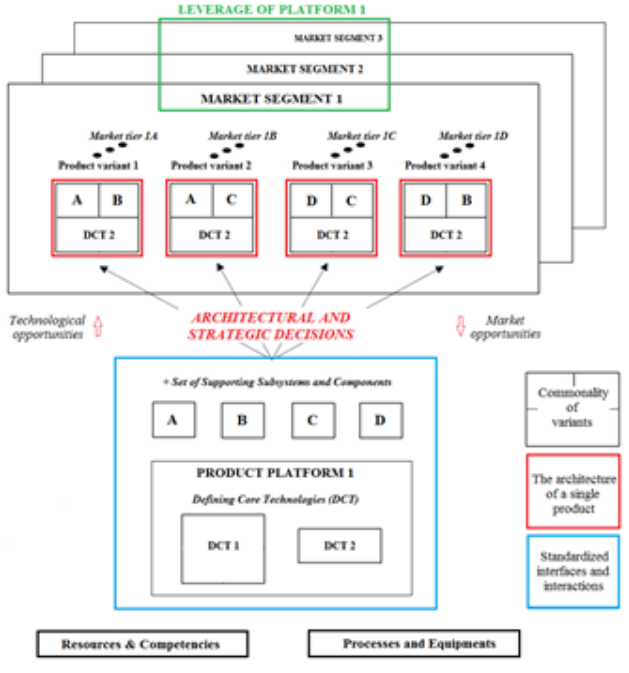
Figure 1. The dynamics of the product family